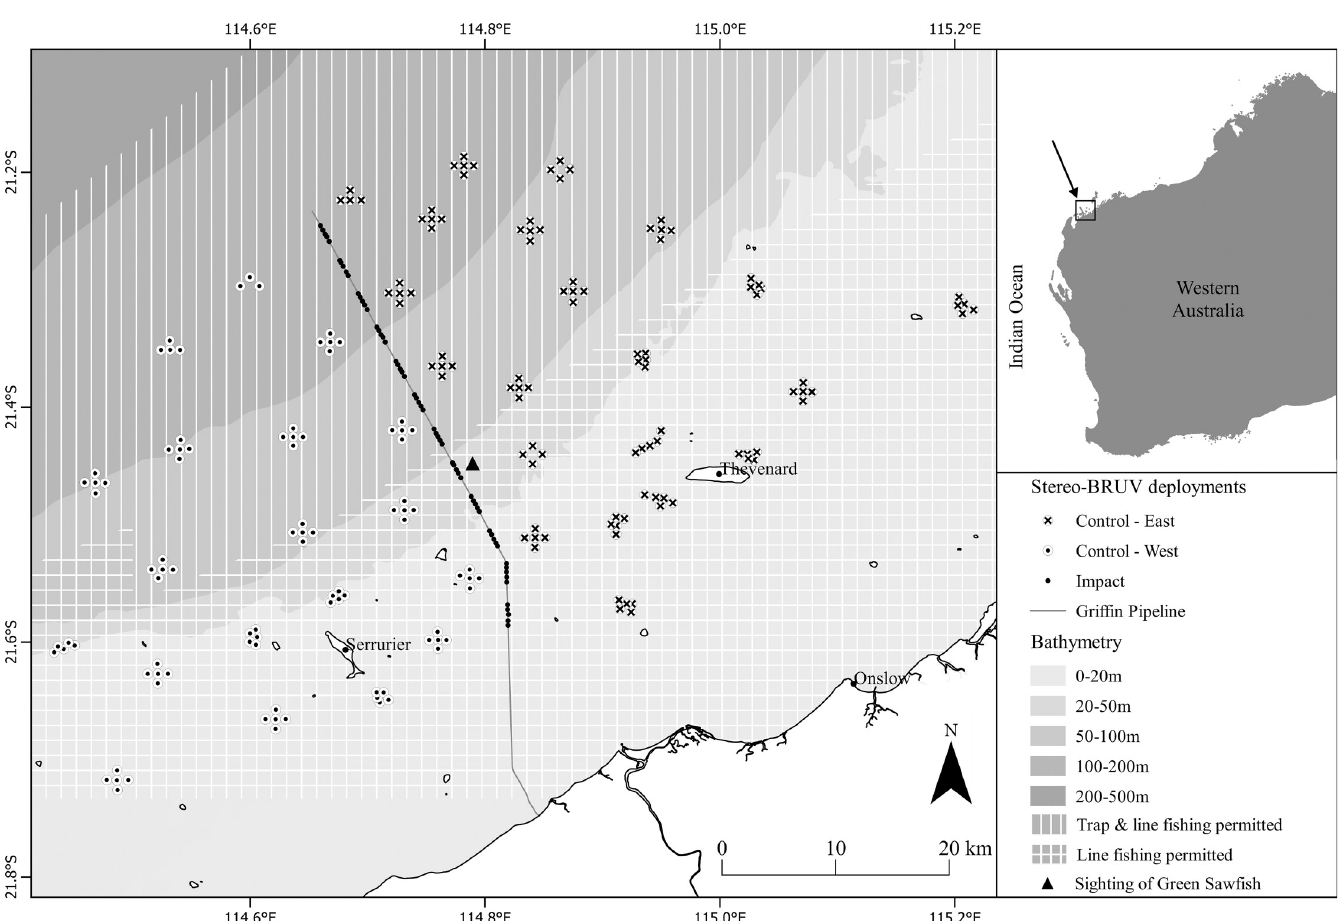
Fig 1. Location of all stereo-BRUV deployments and those analysed. Stereo-BRUV deployments, indicated in red, where visibility was less than 2 m, were excluded from analysis.